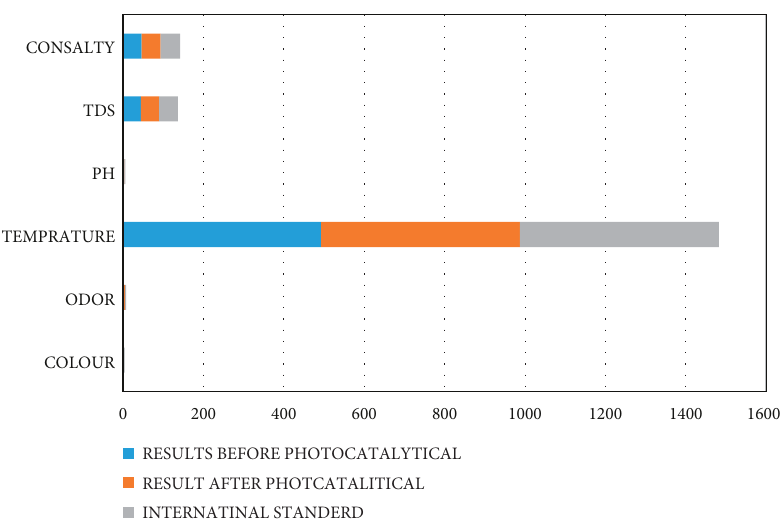
Figure 8: Physiochemical parameters of local dyeing wastewater from Kofar Mata dye pits,